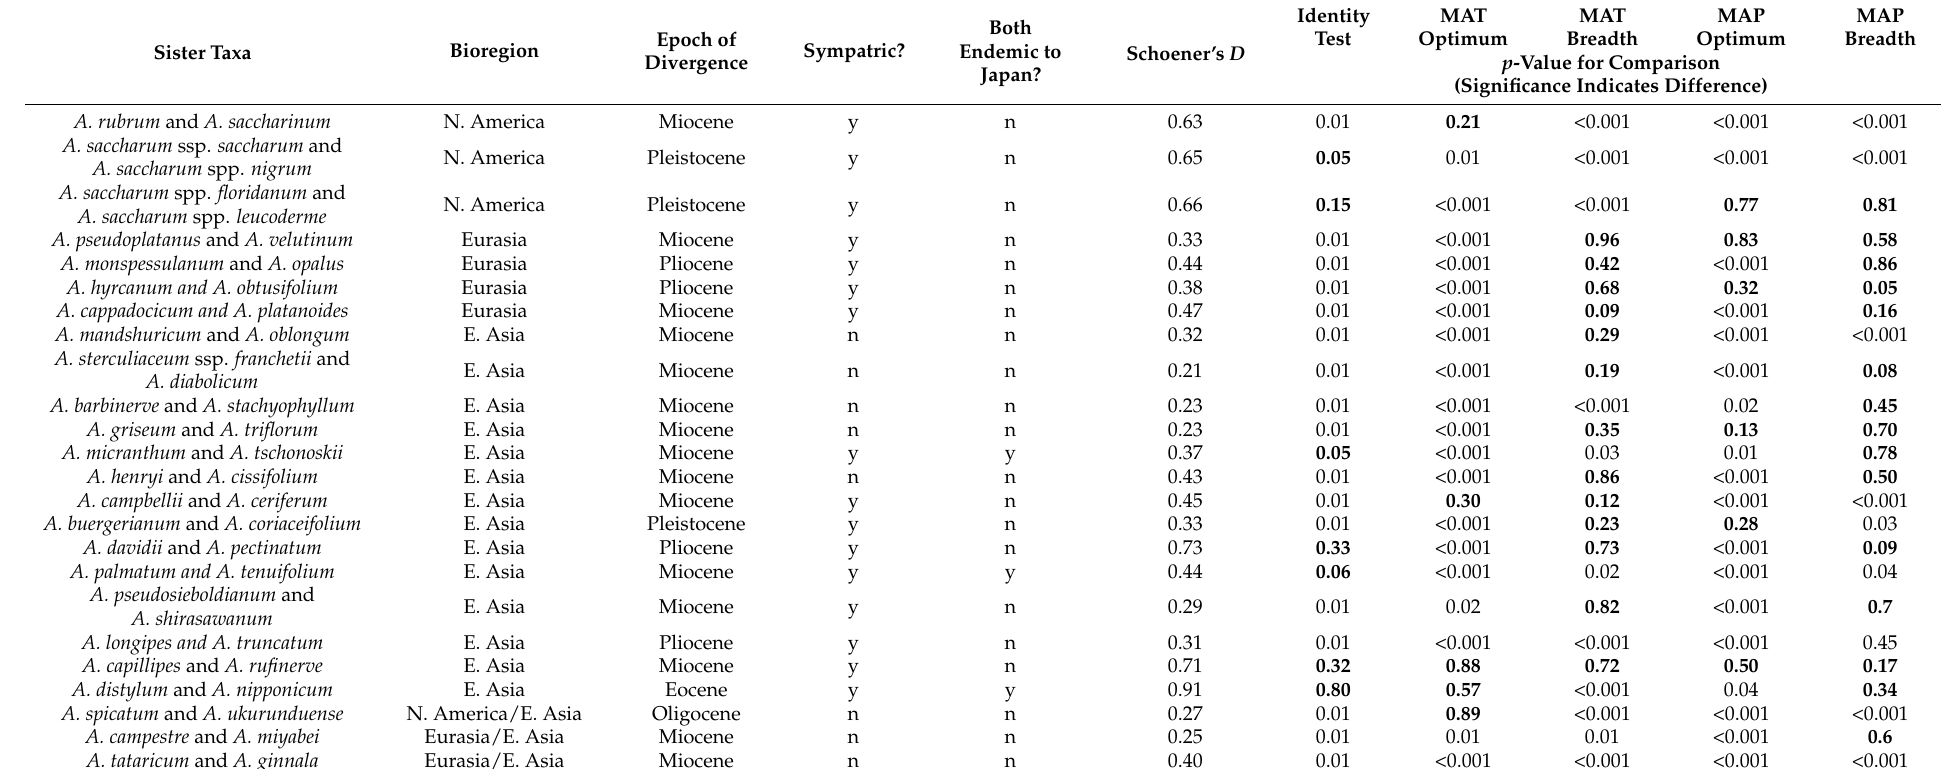
Table 2. Pairwise comparisons of climatic niches for sister taxa * in Acer . 24 sets of taxa are compared; all but three occur in the same continental bioregion. Epoch of divergence is drawn from Areces-Berazain et al. [15]). Pairs include 15 sympatric and 9 allopatric contrasts. Shading separates bioregions. Schoener’s D is given for each pair, indicating the degree of overlap (0 = none, 1 = total overlap) in environmental niche as determined by Maxent modeling. p -values are given for an Identity Test and for permutation tests of similarity in Mean Annual Temperature (MAT) and Precipitation (MAP) optima and breadth. Non-significant p -values are bolded. Data corresponding to pairwise niche comparisons for non-sisters are given in Table